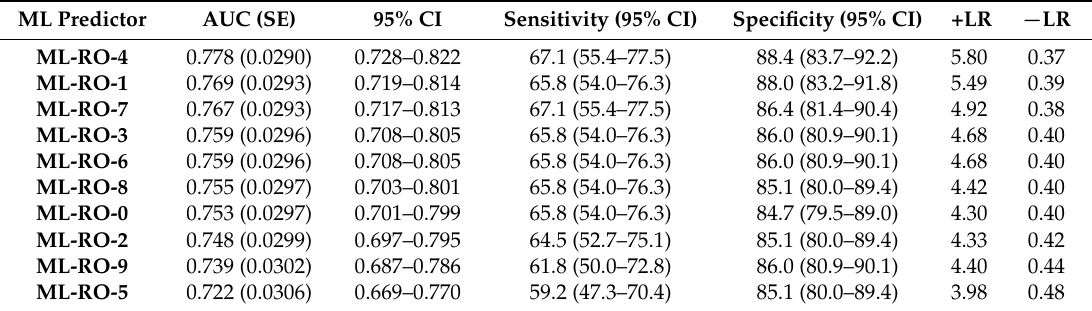
Table 1. Analytical performance of machine learning with random optimization in the training